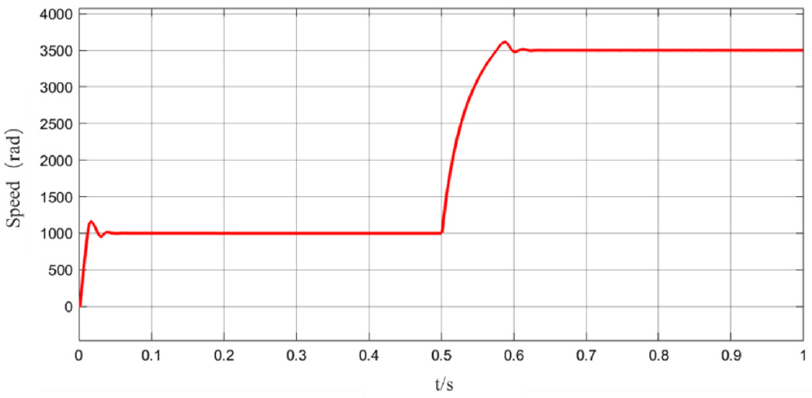
Figure 18. Speed response curve of MRAS algorithm.